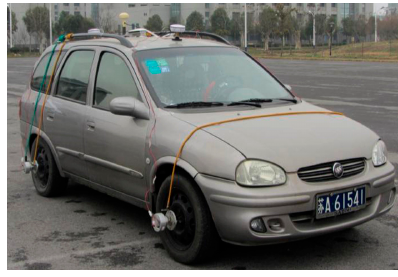
Figure 4. Test vehicle and its configuration.